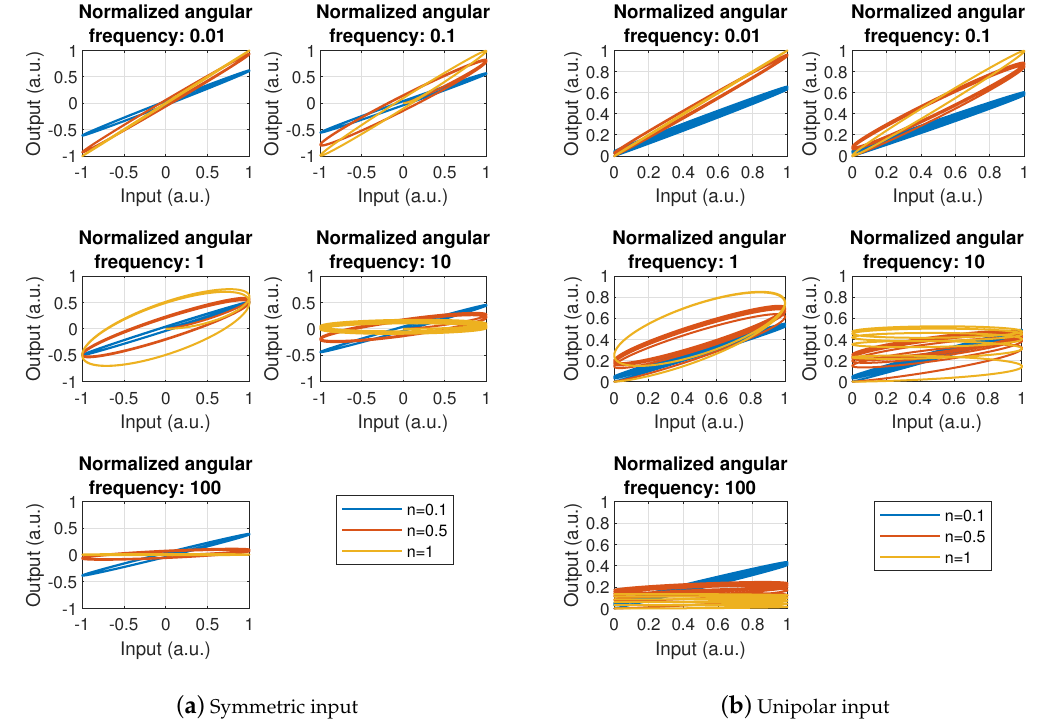
Figure 4. Input (“ in ( s ) ”)-output (“ out ( s ) ”) characteristics of fractional order unit relaxors ( n is the fractional order) at several frequencies (a.u. refers to “arbitrary units”).